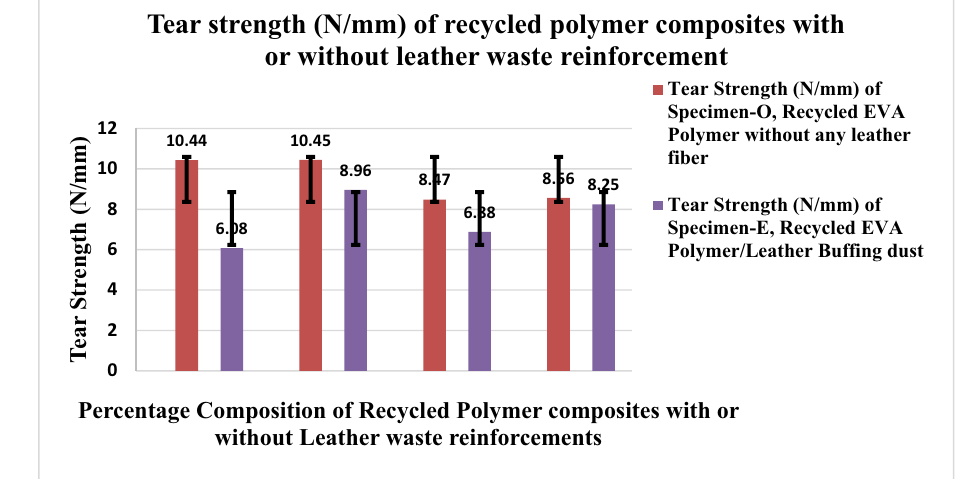
Figure 37: Comparison of tear strength ( N/mm ) of recycled EVA polymer composites with or without leather bu ffi ng